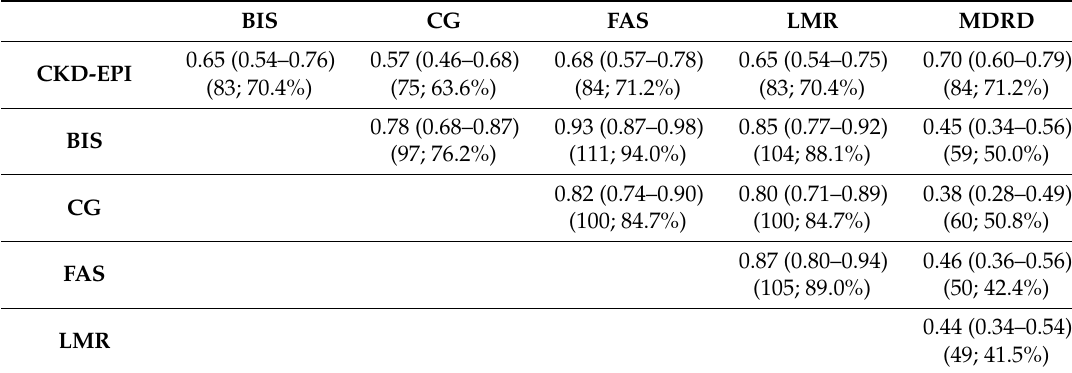
Table 4. The agreement of chronic kidney disease (CKD) stage among the six different creatinine-based eGFR equations in relative values. Weighted kappa coefficient (95% Cl), (number of patients with agreement in CKD stage; percentage patients with agreement in CKD stage).